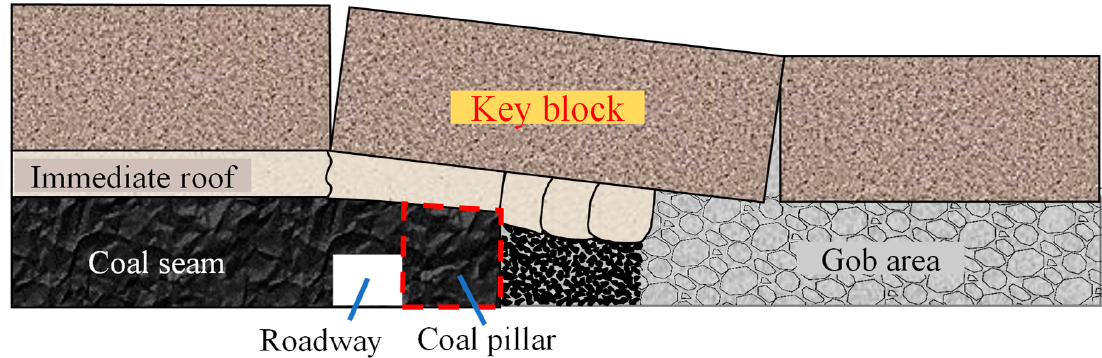
Figure 4. The lateral breaking structure model [46].